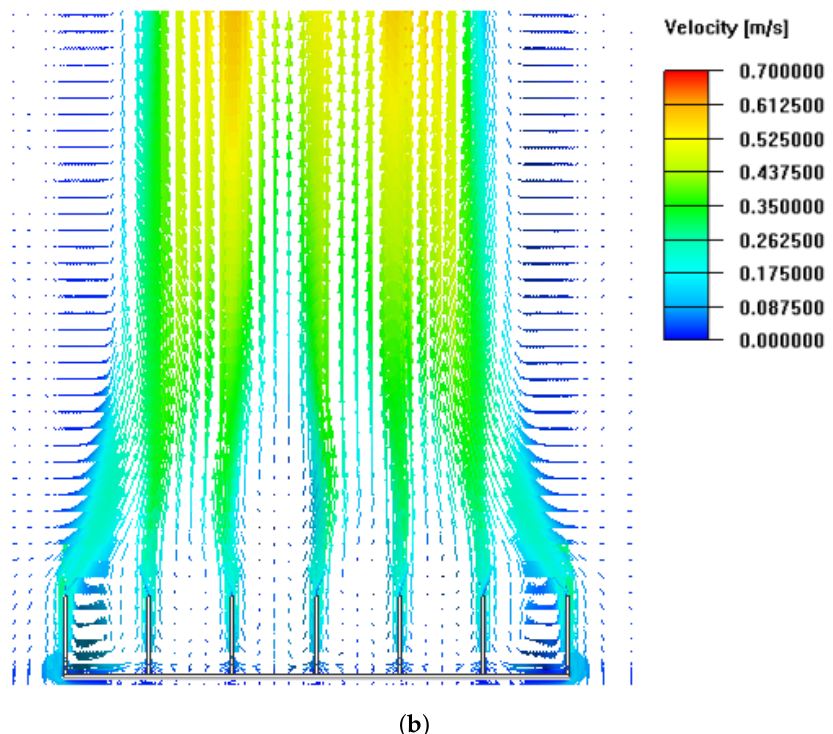
Figure 3. Velocity vectors plotted at the mid-plane in the fin channel with surface openings in the longitudinal direction ( a ) and the transverse direction ( b ) at fin spacing s = 50.8 mm, illustrating the effects of large array width on the plume structure ( L = 254 mm, H = 49.28 mm, n = 7, and ∆ T = 151 ◦